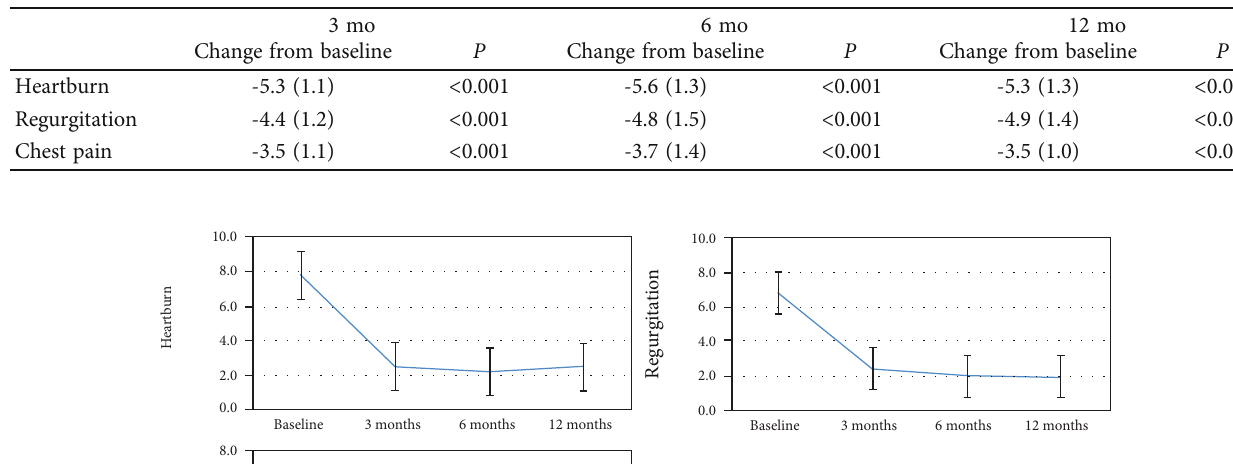
Table 2: Severity of symptoms before and after treatment.